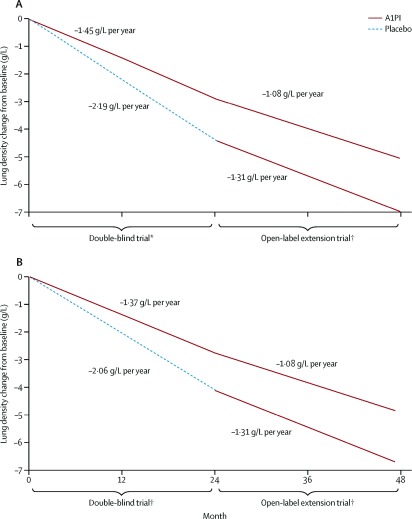
The RAPID trial of augmentation therapy in severe alpha-1 antitrypsin deficiency.Intravenous augmentation therapy slowed the loss of lung density on chest CT scans over four years: (
A) all subjects and (
B) subjects completing the open-label extension study. Reprinted from
5, with permission from Elsevier.